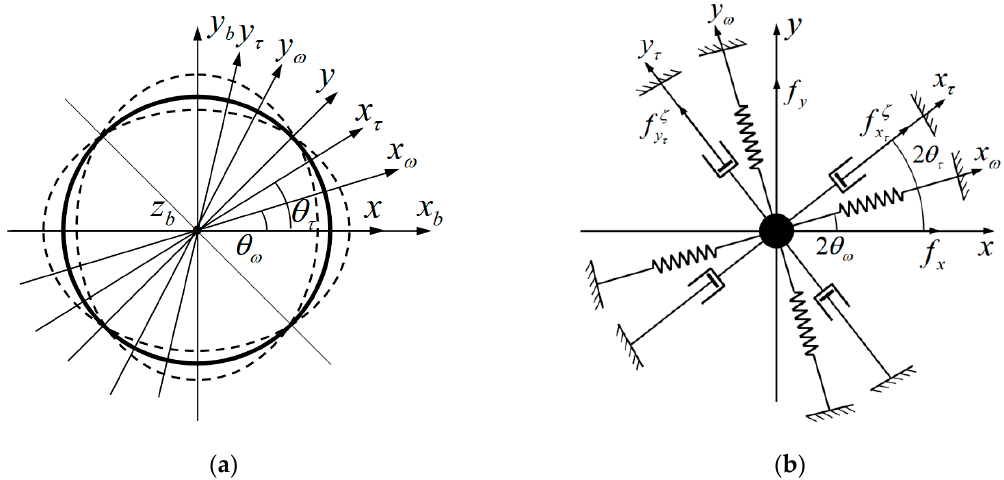
Figure 5. Mechanical model: ( a ) Mechanical model of unideal hemispherical shell resonator; and, ( b ) Equivalent mechanical model of unideal hemispherical shell resonator.